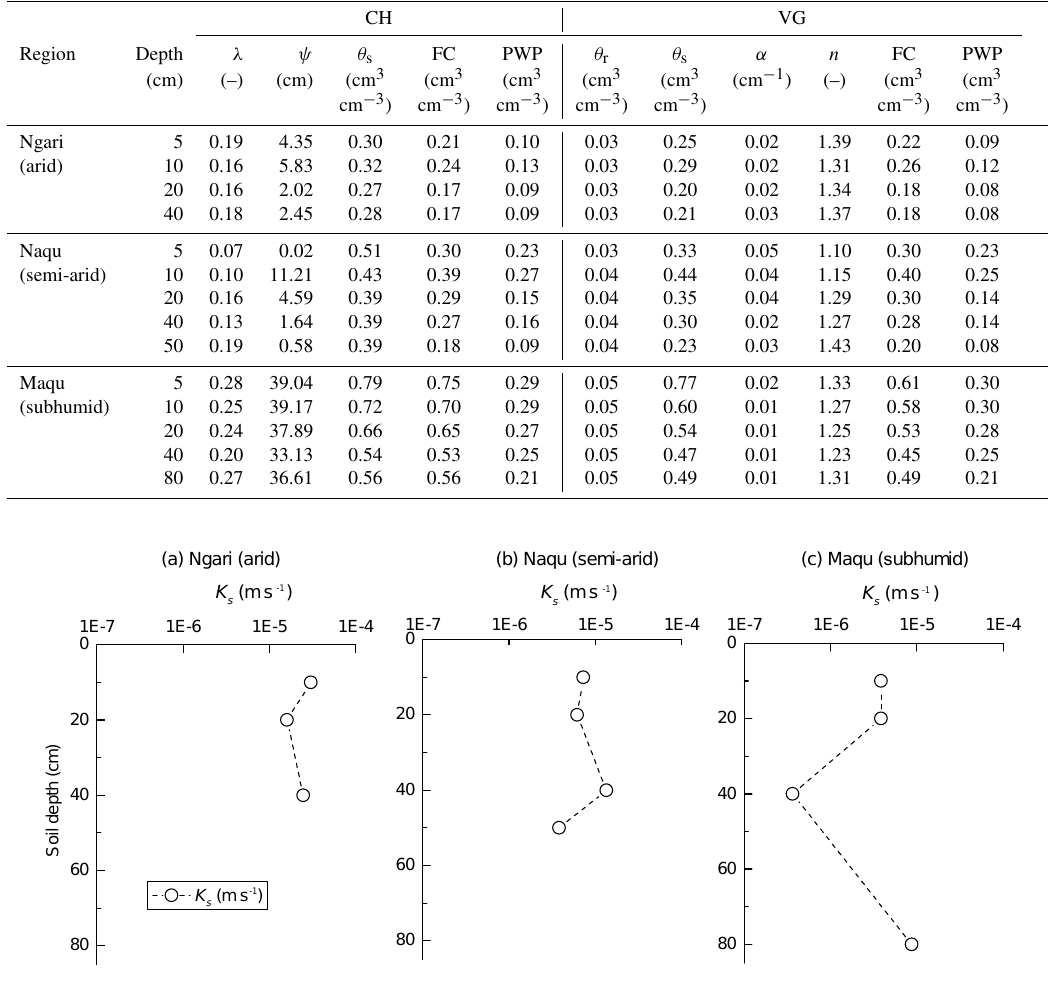
Figure 6. Profiles of mean saturated hydraulic conductivity ( K s ) at three different climate